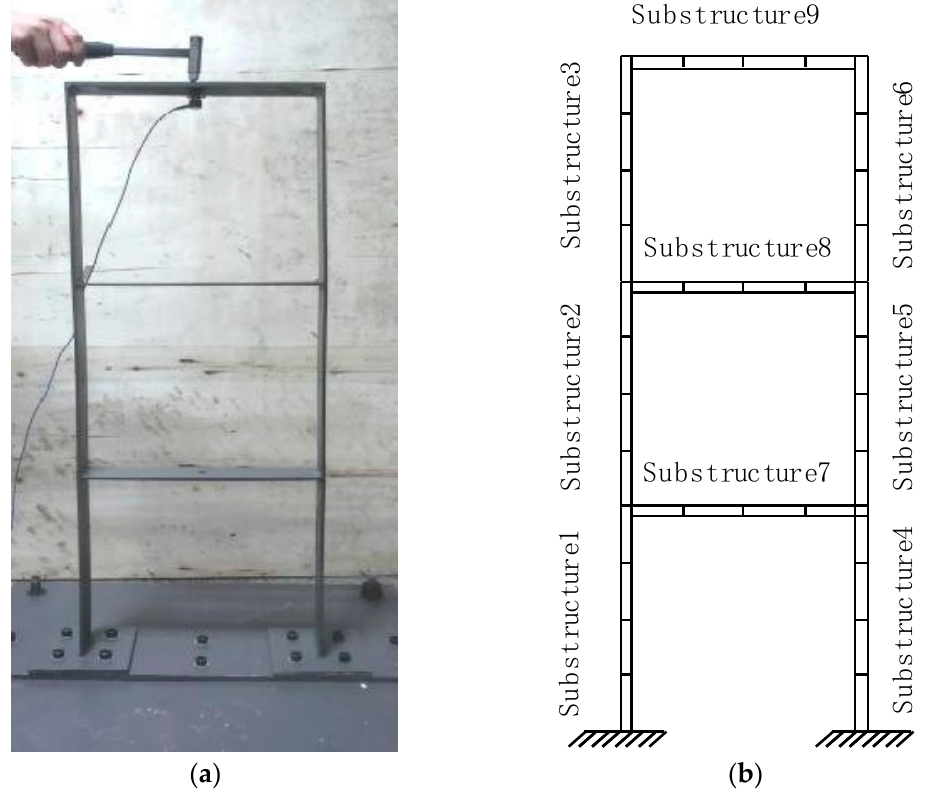
Figure 10. Frame model. ( a ) experimental picture; ( b ) FEM.